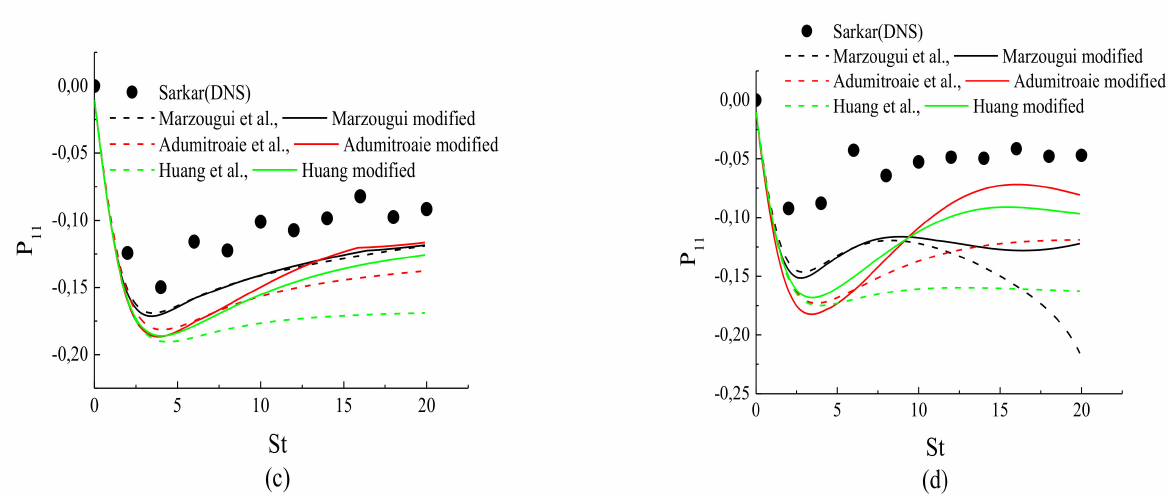
Figure 6. Time evolution of the pressure-strain component, in the following cases: ( a ) A1; ( b ) A2; ( c ) A3; ( d ) A4.